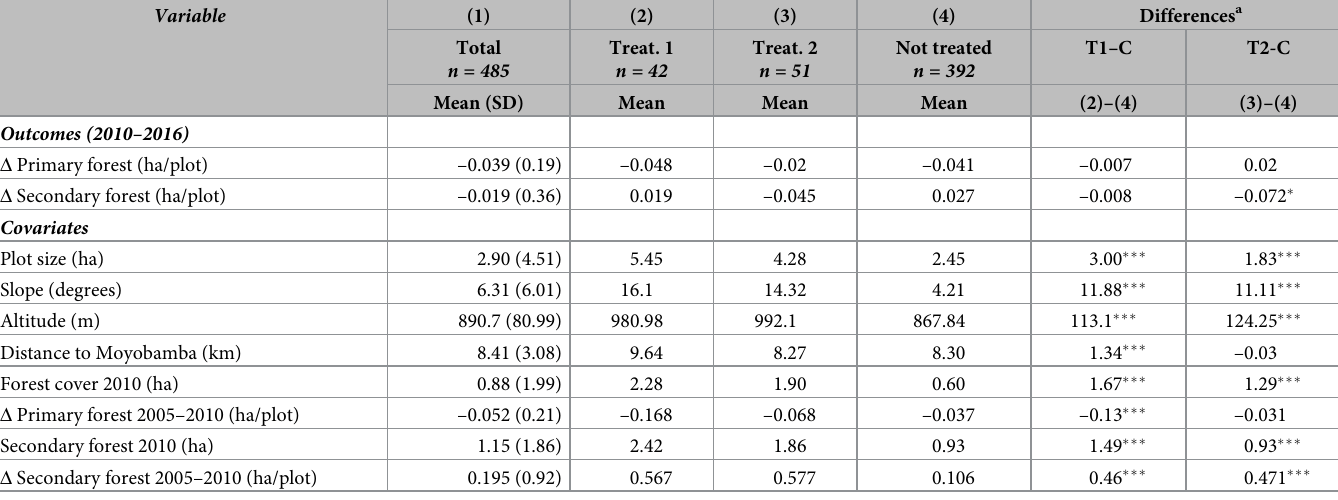
Table 1. Summary statistics for land cover on